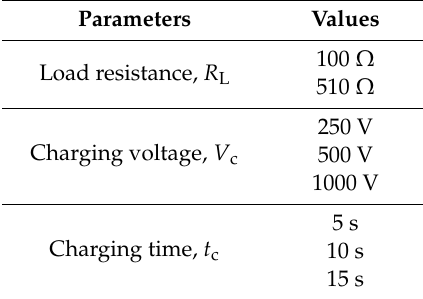
Table 1. List of parameters